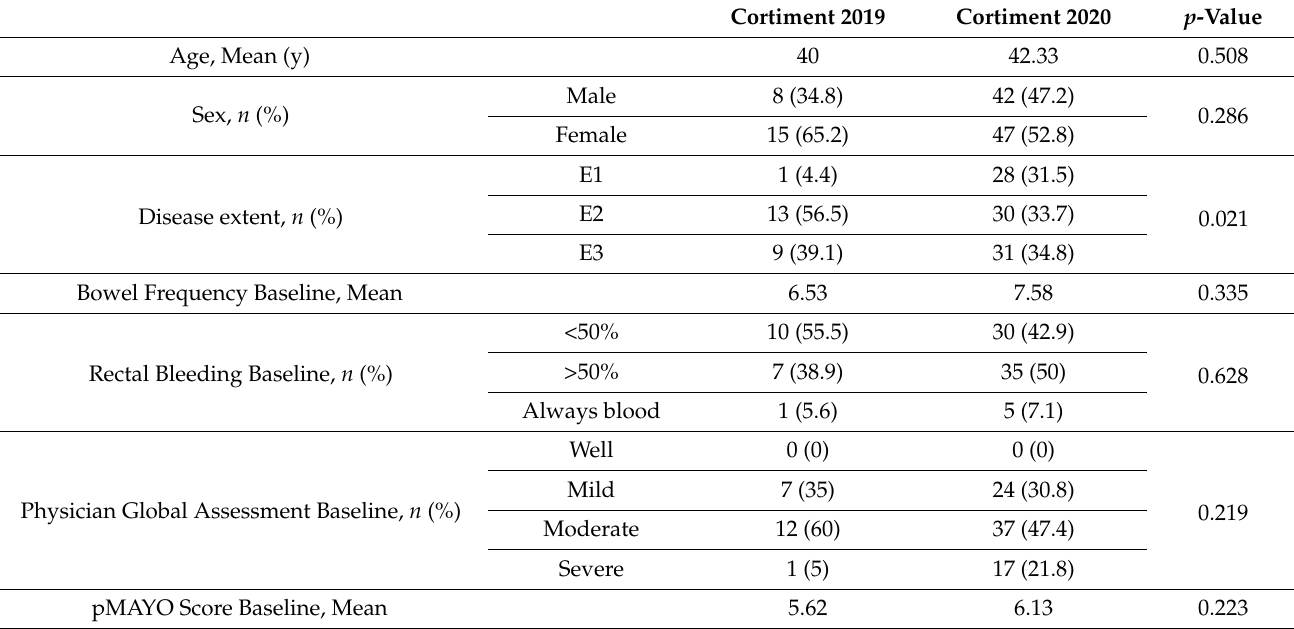
Table 2. Comparison of Cortiment treatment outcomes in 2019 versus